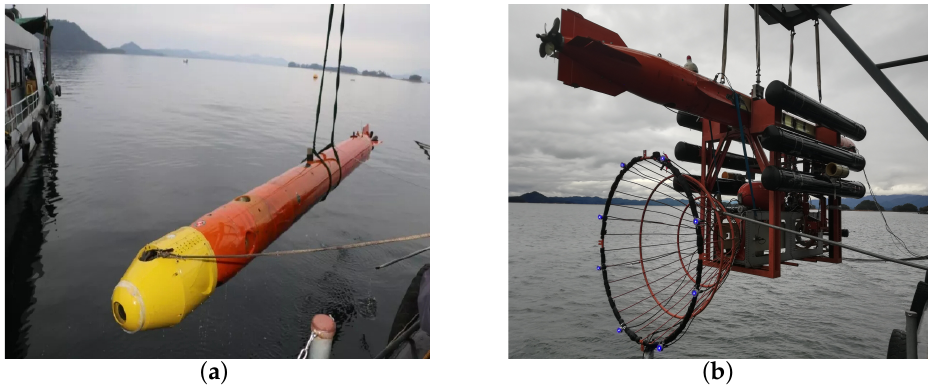
Figure 1. The recovery system consists of ( a ) AUV- II and ( b ) AUV- I with DS . We propose a data pre-processing method for SLAM with unknown measurement error.